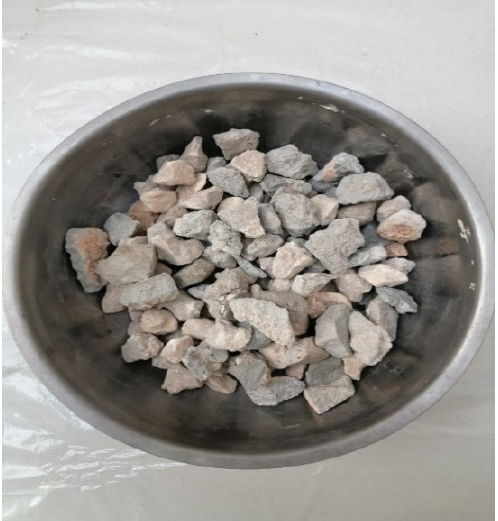
Figure 1. Recycled coarse aggregate (RCA).